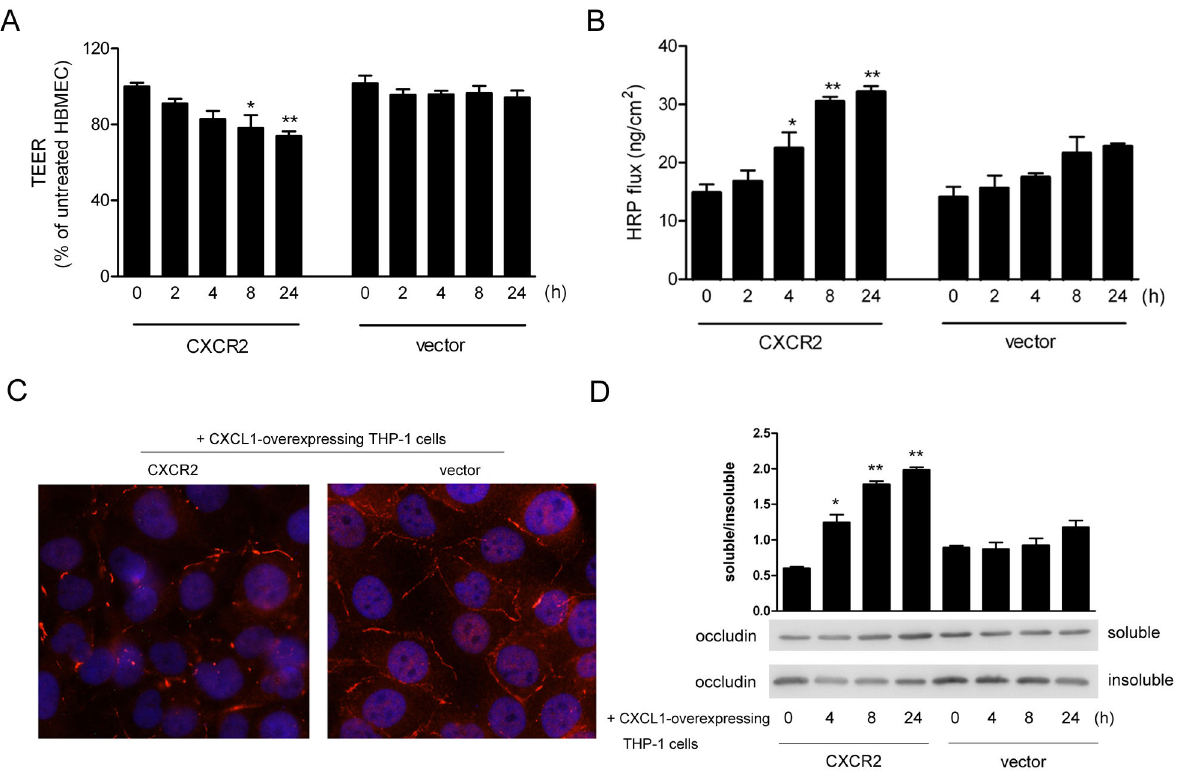
Figure 5. Disassembly of tight junction between brain endothelium over-expressed CXCR2 were induced by CXCL1- overexpressing THP-1 cells. (A) HBMEC transfected with CXCR2 or vector control was seeded into the upper chamber of Transwell insert until they reached confluence. CXCL1-overexpressing THP-1 cells was added to the upper chamber of Transwell insert for the indicated time. Then the TEER was measured by EVOM volt-ohmmeter. The TEER value was expressed as the percent of the 0h. * p < 0.05, ** p < 0.01. (B) HBMEC transfected with CXCR2 or vector control was seeded into the upper chamber of Transwell insert until they reached confluence. CXCL1-overexpressing THP-1 cells was added to the upper chamber of Transwell insert for the indicated time. The medium in the upper chamber was replaced by RPMI-1640 containing 0.5 μM of HRP, and then the medium in the lower chamber was collected and the HRP concentration was assessed. Data were means ± S.D. of three independent experiments. * p < 0.05, ** p < 0.01. (C) CXCL1-overexpressing THP-1 cells was co-cultrued with HBMEC transfected with CXCR2 or vector control on sterilized coverslips for 24h. The distribution of ZO-1 in the HBMEC was visualized by immunofluorescence. Nuclei were counterstained with DAPI. Scale bar: 40 μm. (D) CXCL1-overexpressing THP-1 cells was co- cultrued with HBMEC transfected with CXCR2 or vector control for the indicated time. The soluble and insoluble forms of occludin were analyzed by Western Blot. * p < 0.05, ** p <